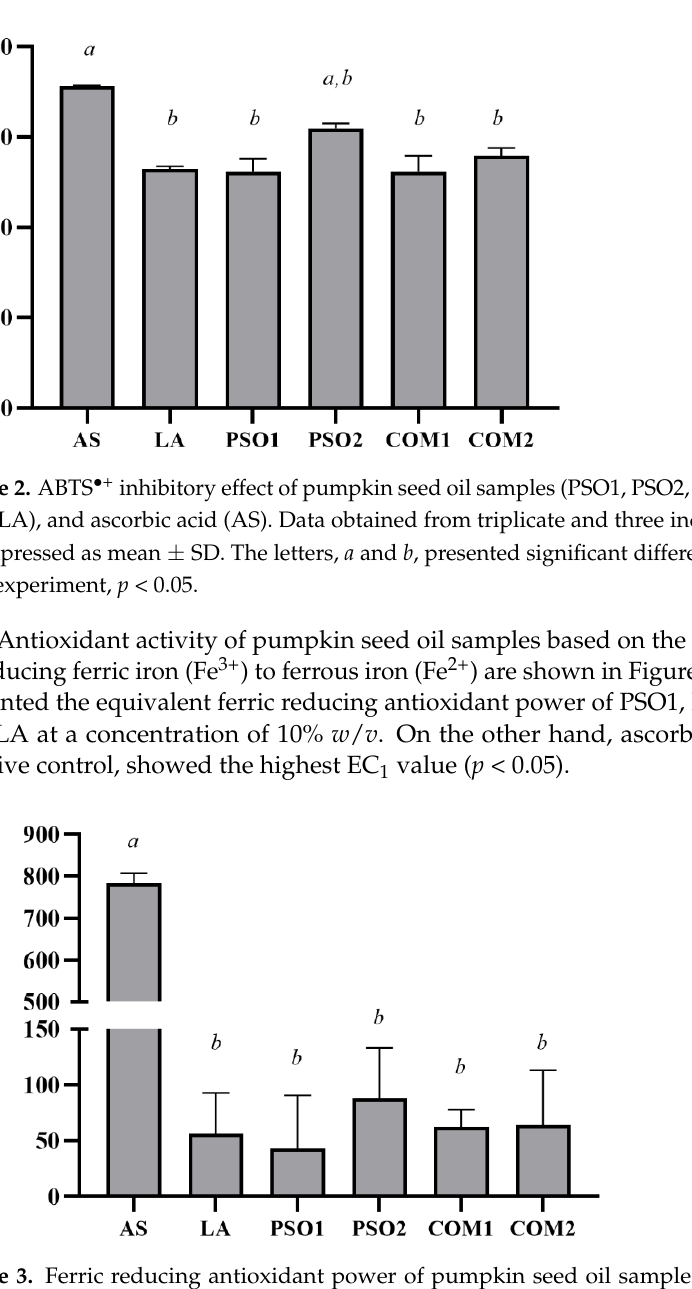
Figure 3. Ferric reducing antioxidant power of pumpkin seed oil samples (PSO1, PSO2, COM1, COM2), linoleic acid (LA), and ascorbic acid (AS). Data obtained from triplicate and three independ-